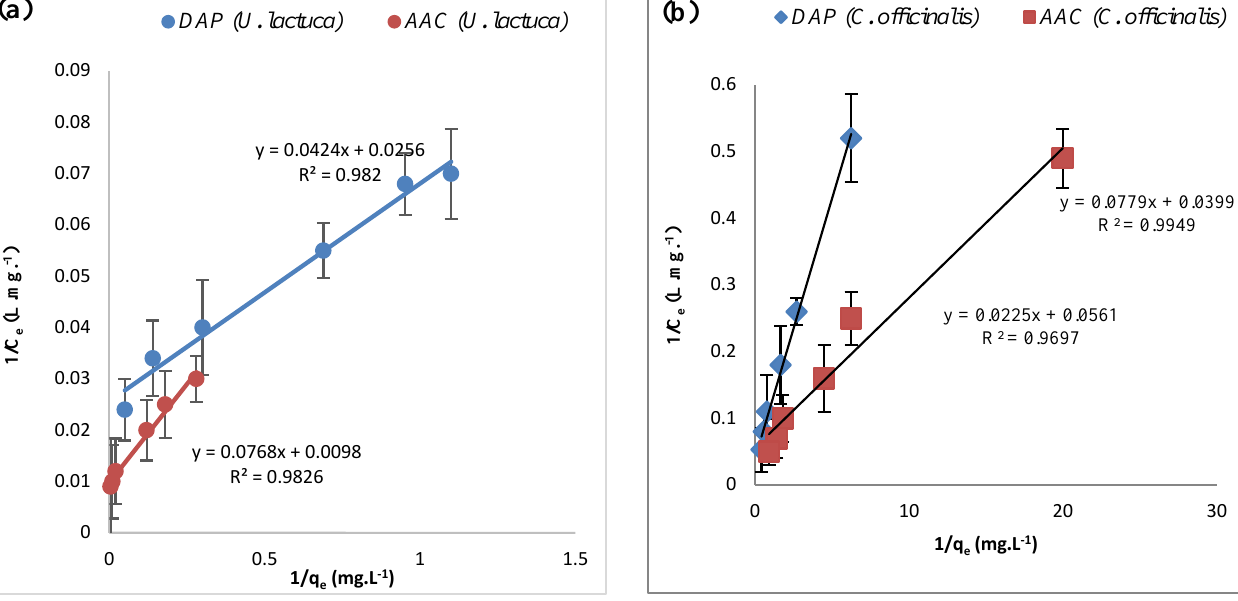
Figure 7. ( a , b ). Langmuir’s adsorption isotherm for Zn +2 on DAP and AAC of ( a ) Ulva lactuca ( b ) Corallina officinalis . Each data point represents the mean ±